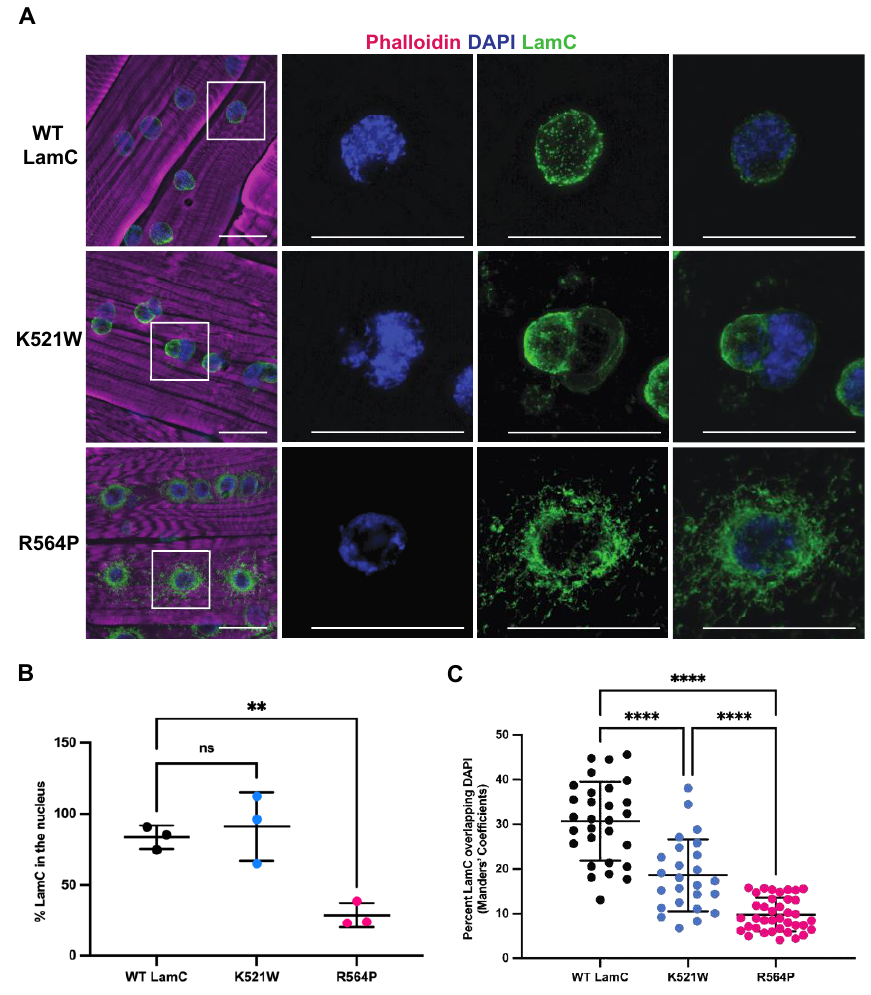
Figure 2. LamC K521W and R564P show different patterns of LamC immunostaining. ( A ) Larval body wall muscles expressing either wild-type or mutant LamC were stained with phalloidin (magenta), DAPI (blue), and antibodies to LamC (green). Note the abnormal nuclear morphology caused by LamC K521W and the cytoplasmic lamin aggregation caused by LamC R564P. The white box outlines the magnified region shown on the right. The scale bar represents 30 µ m. ( B ) A graph of the average percent of nuclear LamC in each genotype is shown. The subcellular location of LamC was quantified based on the intensity of immunofluorescent staining in the nucleus compared to the total intensity from three-channel microscopy images of larval body wall muscles. ( C ) A graph of the quantification of the overlap of LamC and DAPI in larval body wall muscles is shown. The Manders’ coefficient was calculated using JACoP for the fraction of staining in the green channel (LamC) that overlaps with staining in the blue channel (DAPI). A total of 25 to 38 nuclei from three individual larvae per genotype were analyzed. Error bars represent the standard deviation of the mean. The values in the graph are expressed as mean ± standard deviation. A total of 15-34 nuclei were analyzed from three larvae per genotype. For panels ( B , C ), statistical significance was determined using a one-way ANOVA multiple comparisons analysis followed by Dunnett’s correction (GraphPad Prism version 9.5.0, GraphPad Software, San Diego, CA, USA) and is indicated by: not significant (ns), p > 0.05; **, p < 0.01; ****, p < 0.0001.